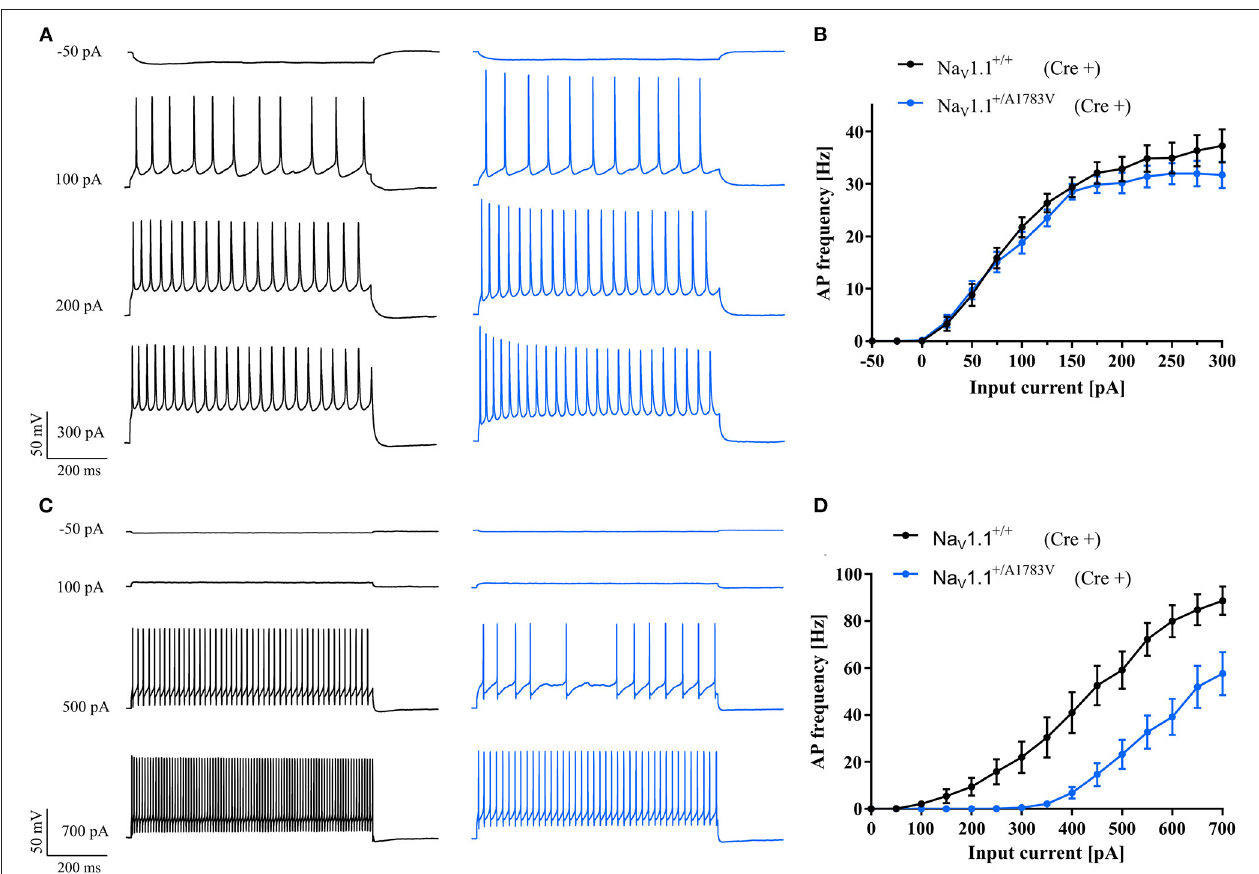
FIGURE 3 | In vitro studies of neuronal excitability. (A) Representative AP trains in response to 800ms step current injections from cortical PCs and (C) fast-spiking interneurons recorded in brain slice cultures of WT (black traces) and heterozygous Na V 1.1 + / A1783V animals (blue traces). (B) f - I curves of PCs from floxed heterozygous mice showed the same frequency of action potential firing while (D) fast-spiking inhibitory neurons showed higher and maintained lower AP frequencies compared to cells of WT animals. A number of recorded cells, exact values of statistically analyzed parameters, and p -values are listed in Supplementary Tables 2, 3